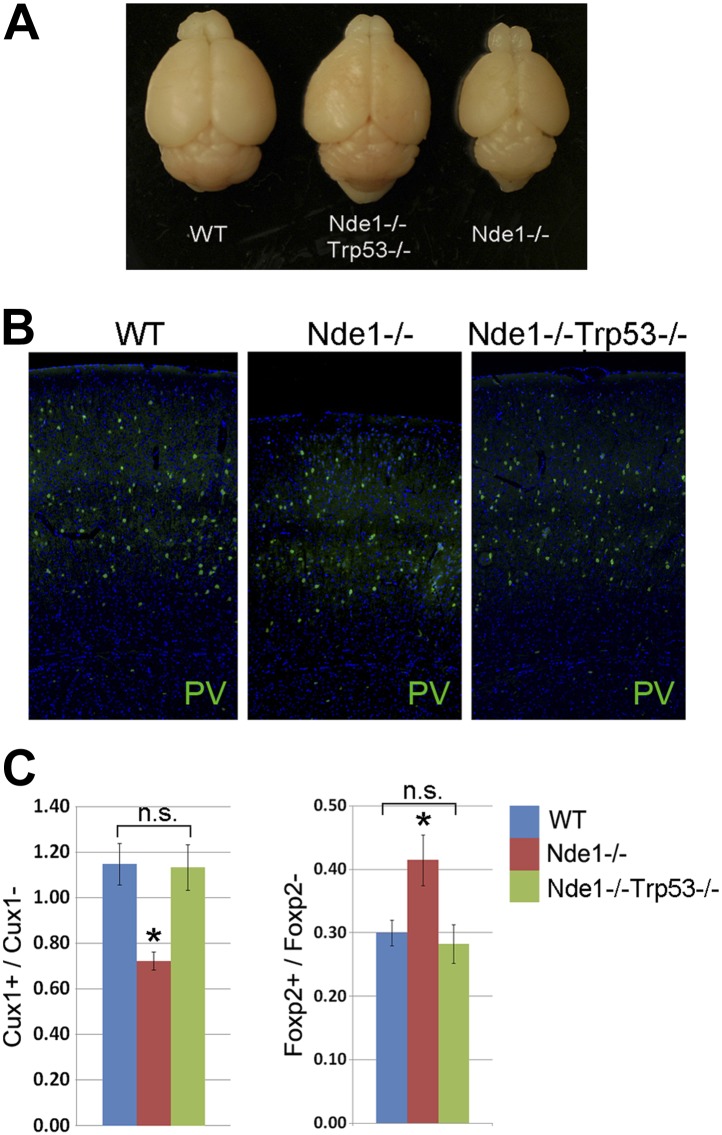
Restoration of brain size and structure of Nde1−/− mutants by abrogating p53.(A) Representative brain images of wild-type, Nde1−/−, and Nde1−/−Trp53−/− mice at post-natal day 23. (B) Immunostaining with parvalbumin antibody (PV) showing the normal number and distribution of GABAergic interneurons in the Nde1−/−Trp53−/− cortex. Nuclei DNA was stained with Hoechst 33342 and shown in blue. (C) Quantitative analyses of Cux+ superficial and Foxp2+ deep layer cortical neurons. Data are presented as mean ± SD (n = 5). Significant overall differences were found among wild-type, Nde1−/−, and Nde1−/−Trp53−/− brains by ANOVA (p < 0.0001 for Cux1+; p = 0.0009 for Foxp2+ neurons). Pairwise comparisons indicated that compared to the wild-type, Cux1+ neurons were significantly decreased in the Nde1−/− brains (*p < 0.0001) but not significantly changed in Nde1−/−Trp53−/− brains (n.s., p = 0.95). Compared to Nde1−/−, Cux1+ neurons were significantly increased in Nde1−/−Trp53−/− brains (p < 0.0001). Compared to the wild-type, Foxp2+ neurons were significantly increased in the Nde1−/− brains (*p = 0.0045), but not significantly changed in Nde1−/−Trp53−/− brains (n.s., p = 0.72). Compared to Nde1−/−, Foxp2+ neurons were significantly decreased in Nde1−/−Trp53−/− brains (p = 0.001).